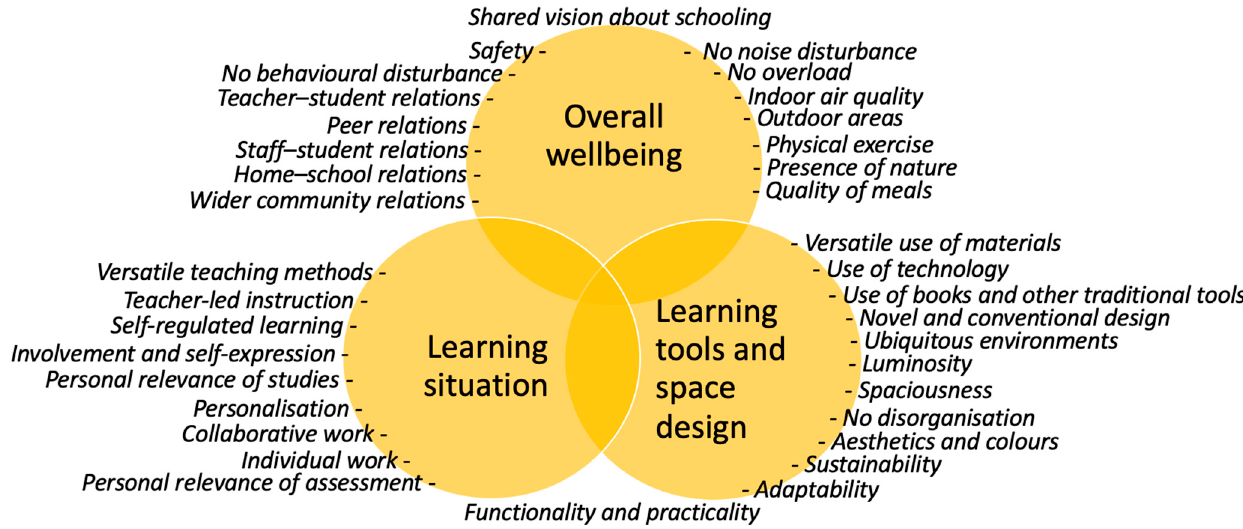
Figure 1. Learning environment design (LED) framework V1.0: Constructs and characteristics selected based on the literature review (Example literature, see [2–12,20,33,34,37–67])